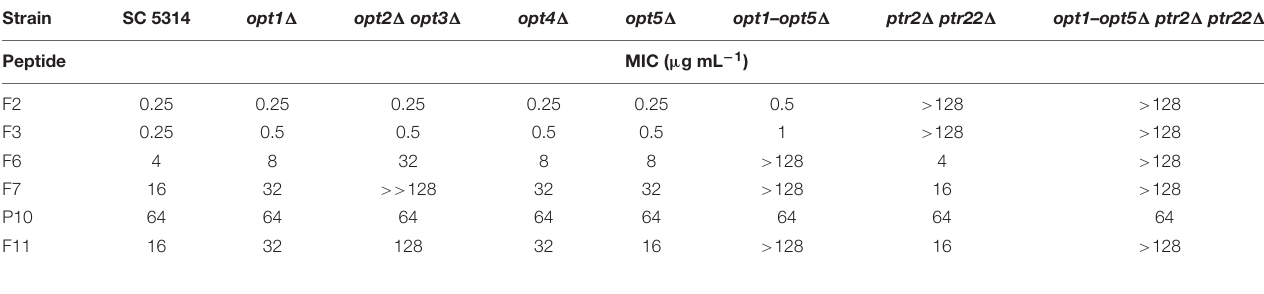
TABLE 5 | Growth inhibitory in vitro activity of FMDP-oligopeptides against C. albicans wild type cells and oligopeptide transporters-deficient mutants determined in RPMI-1640 medium.